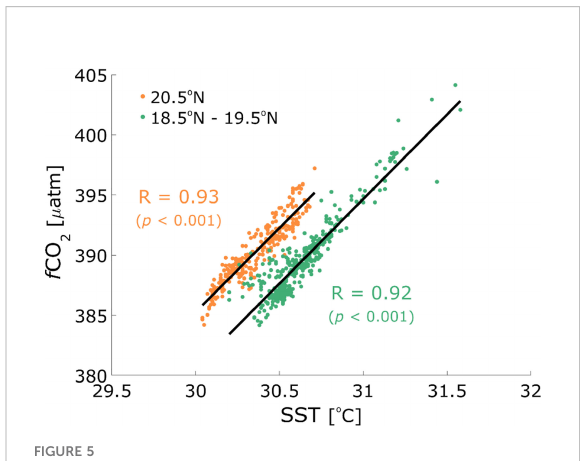
FIGURE 5 Plots of f CO 2 vs. SST in the anticyclonic eddy. Solid lines indicate linear regressions at 20.5°N and 18.5°N-19.5°N